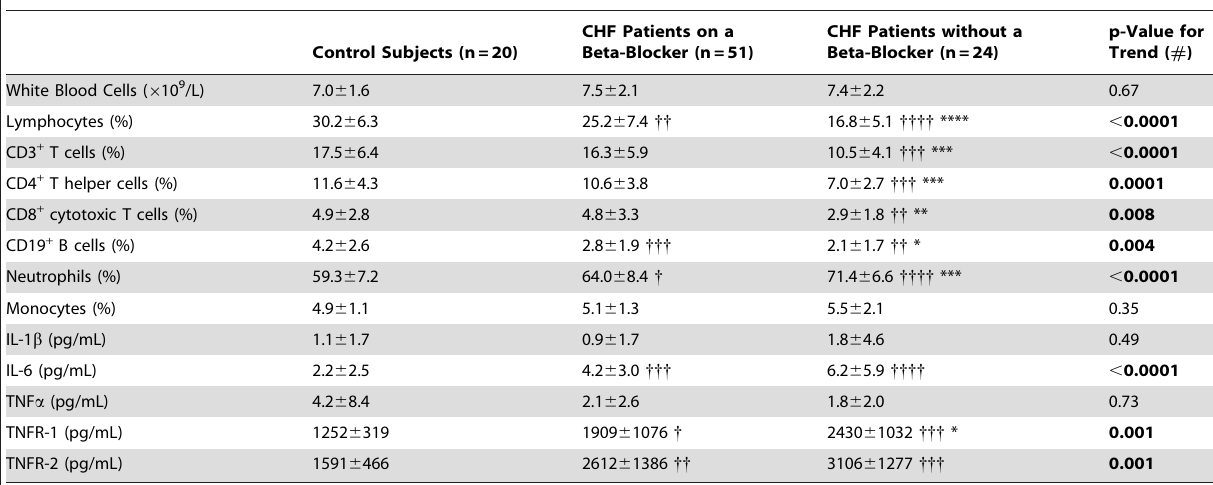
Table 4. Effect of b -blockers.